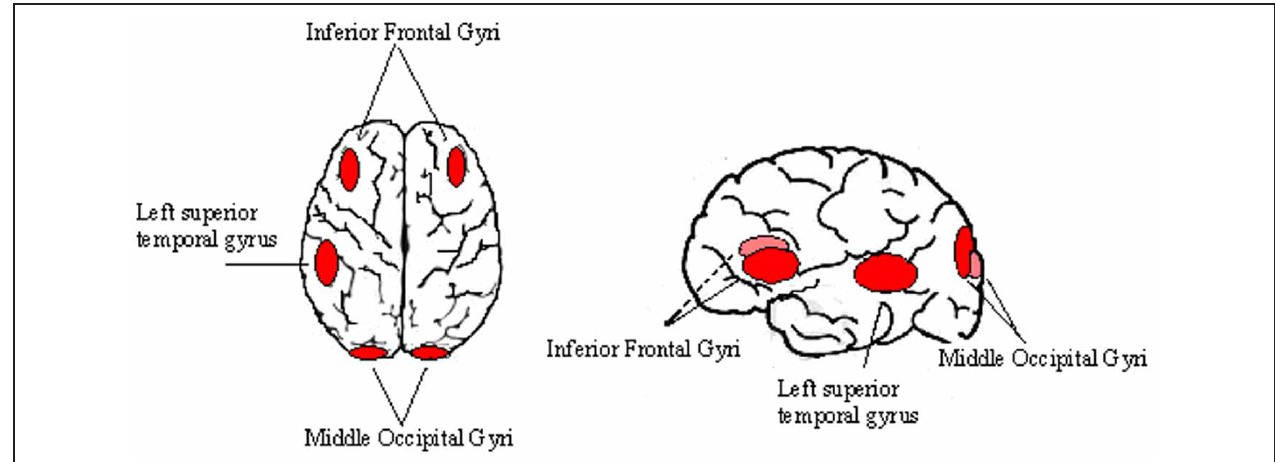
FIGURE 1 | Cortical areas involved in compensatory processes of childhood dyslexia. Some cortical regions such as the IFG, the left STG and the middle occipital gyri were reported to be hypo-active in